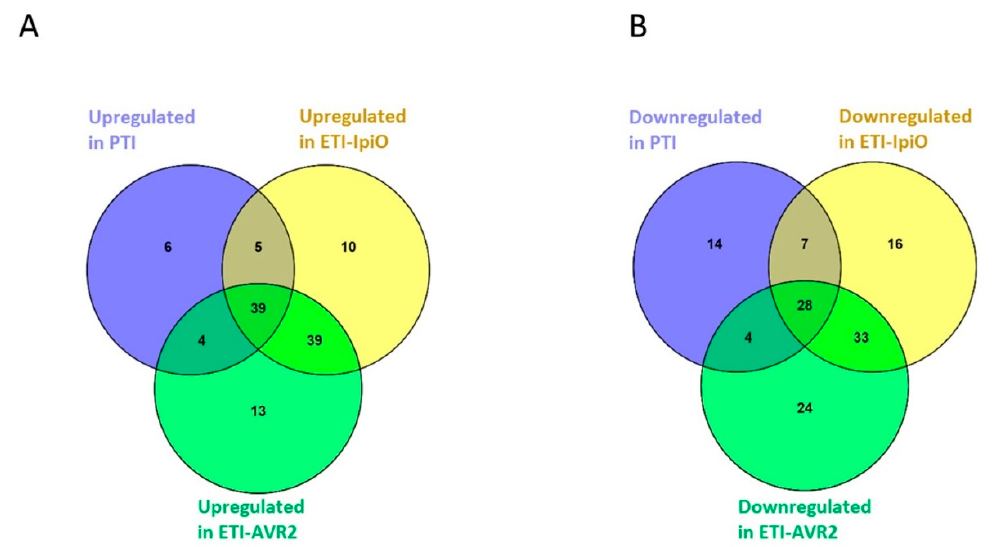
Figure 1. Diagram representing the results of the analysis with the respective number of proteins significantly changed in abundance in PAMP (pathogen-associated molecular patterns) triggered immunity (PTI) and effector-triggered immunity (ETI) interactions (Blb1-IpiO and AVR2-R2), on both ( A ) upregulated and ( B ) downregulated proteins.